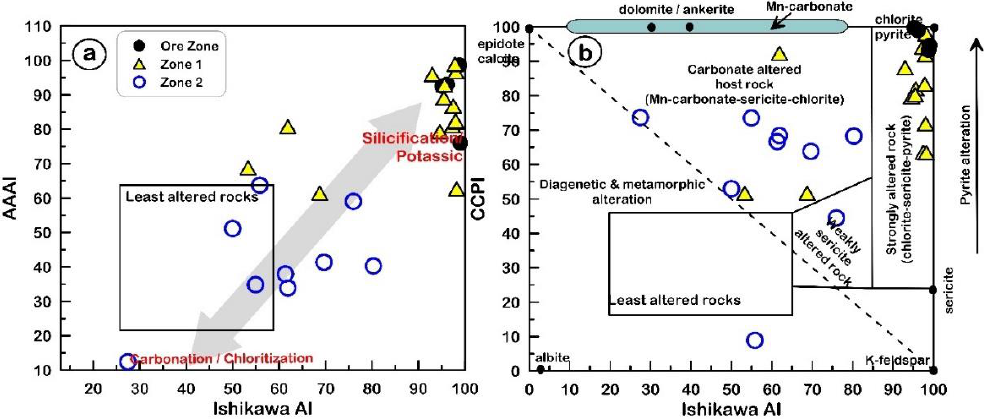
Figure 11. ( a ) AI [45] vs. AAAI [46]; ( b ) AI [45] vs. CCPI [47] of the studied alteration samples from the Halılar area.